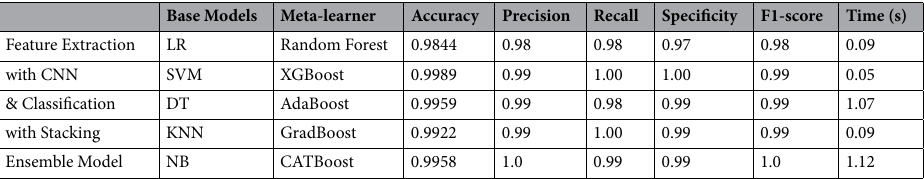
Table 4. Performance analysis of test data using proposed technique (Technique 4).